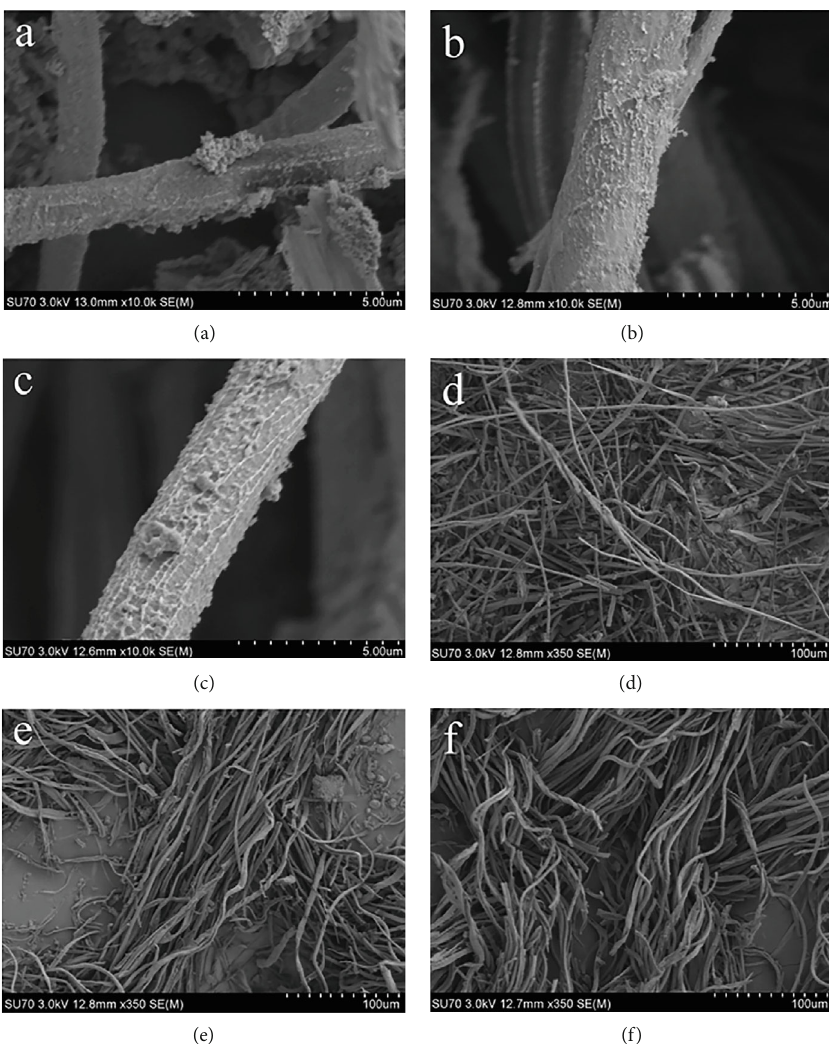
Figure 7: SEM images of carbon residues: (a, d) Cotton@S-2, (b, e) Cotton@S-3, and (c, f)